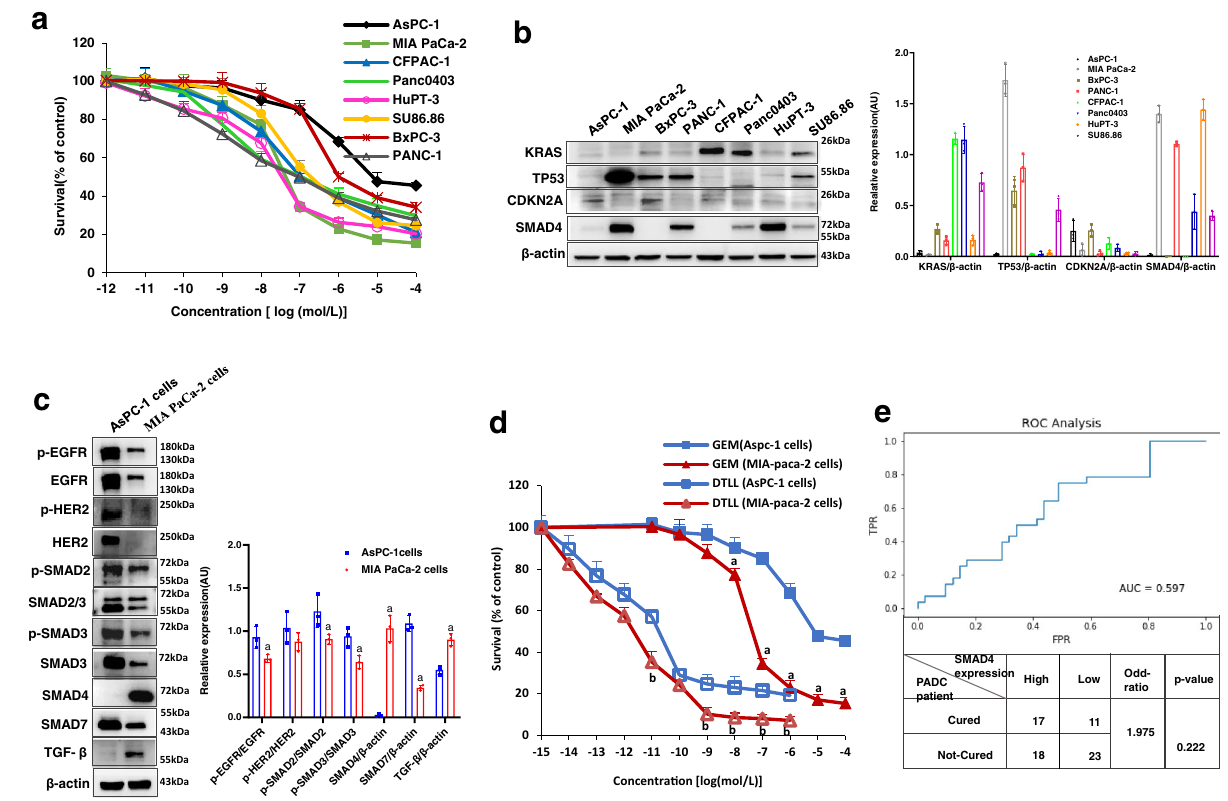
Fig.1|DifferencesindrugsusceptibilityandPDACdriversbetweenAsPC-1cells andMIAPaCa-2cells.a Drugresponsestogemcitabineofeighthumanpancreatic cancercelllines.AsPC-1, MIAPaCa-2,BxPC-3,PANC-1,CFPAC-1,Panc0403,HuPT-3, and SU86.86 cells were exposed to various concentrations of gemcitabine (GEM) for 72h and cell viability was measured by the MTS assay. Data are shown as the mean±SD from three biologically independent experiments ( n =3). b The protein expressionofKRAS,TP53,CDKN2A,andSMAD4ineightpancreaticcancercelllines was analyzed by Western blot assay, and quantitative evaluation for each line